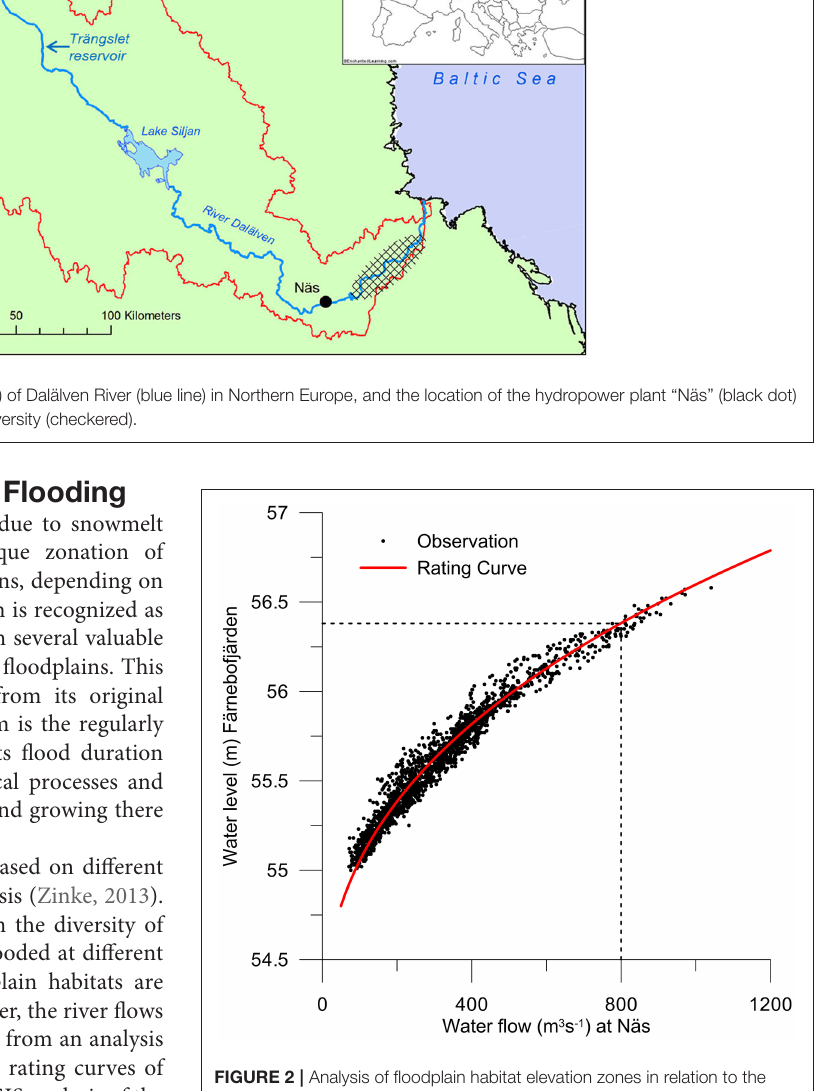
FIGURE 2 | Analysis of floodplain habitat elevation zones in relation to the observed and modeled stage-discharge rating curve for Färnebofjärden in Lower Dalälven. In order to flood riparian mixed forest habitats (Natura 2000 habitat code 91F0) a river discharge exceeding 800 m 3 s − 1 is